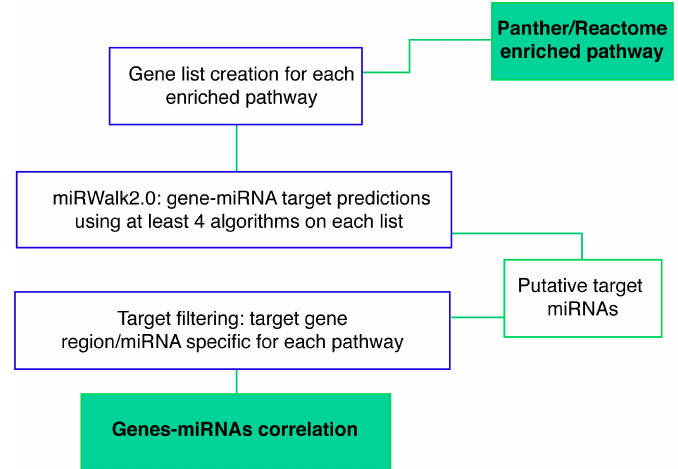
Figure 9. Workflow of the integrative analysis of Gene-miRNA target prediction. The input data included the target genelist of each enriched pathway. Predicted gene-miRNA by miRWalk2.0 was filtered for specific miRNA and specific brain region (SVZ, STR), and gene-miRNA correlation was identified.